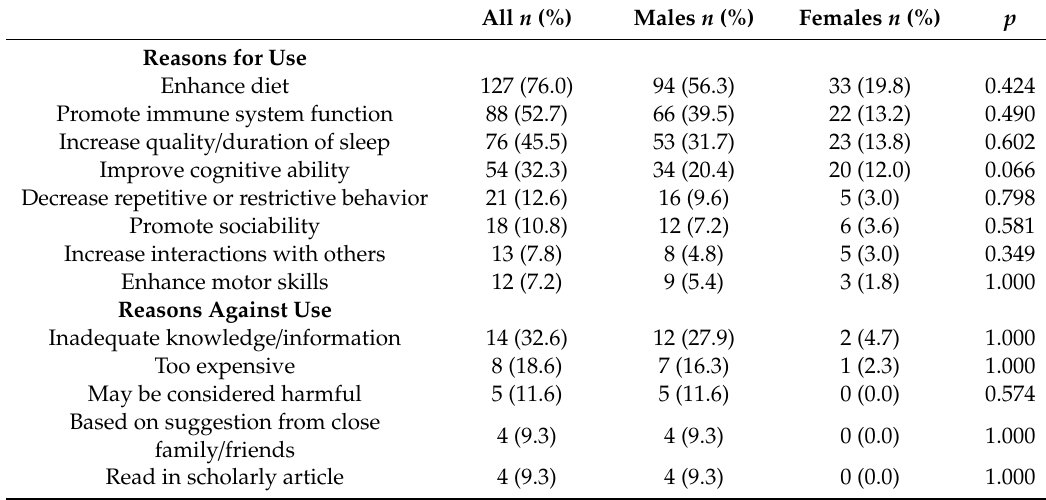
Table 3. Reasons for and against dietary supplement use.